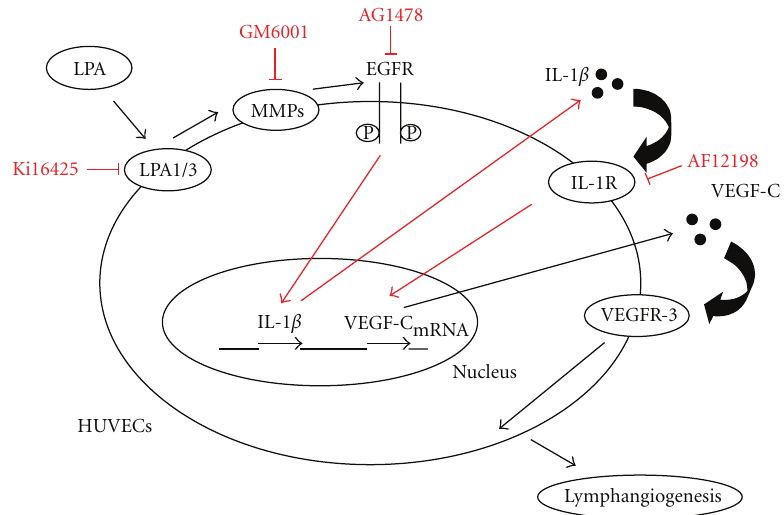
Figure 5: Proposed mechanisms of lysophosphatidic acid- (LPA-) induced lymphangiogenesis in human endothelial